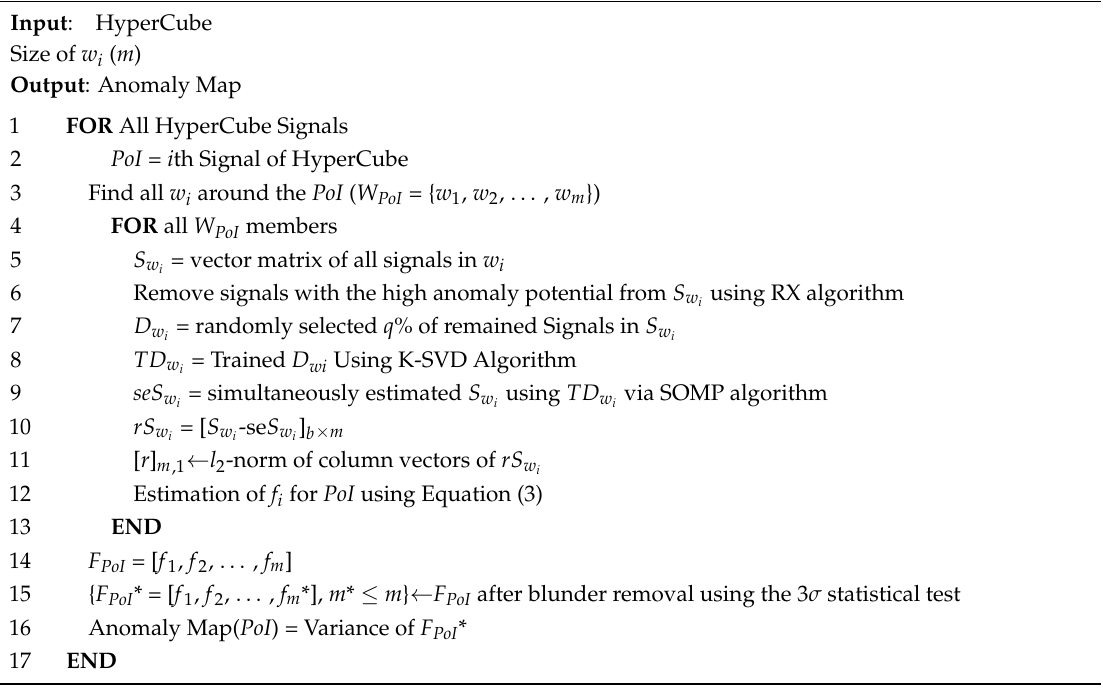
Algorithm 1. SWJSR Anomaly Detector